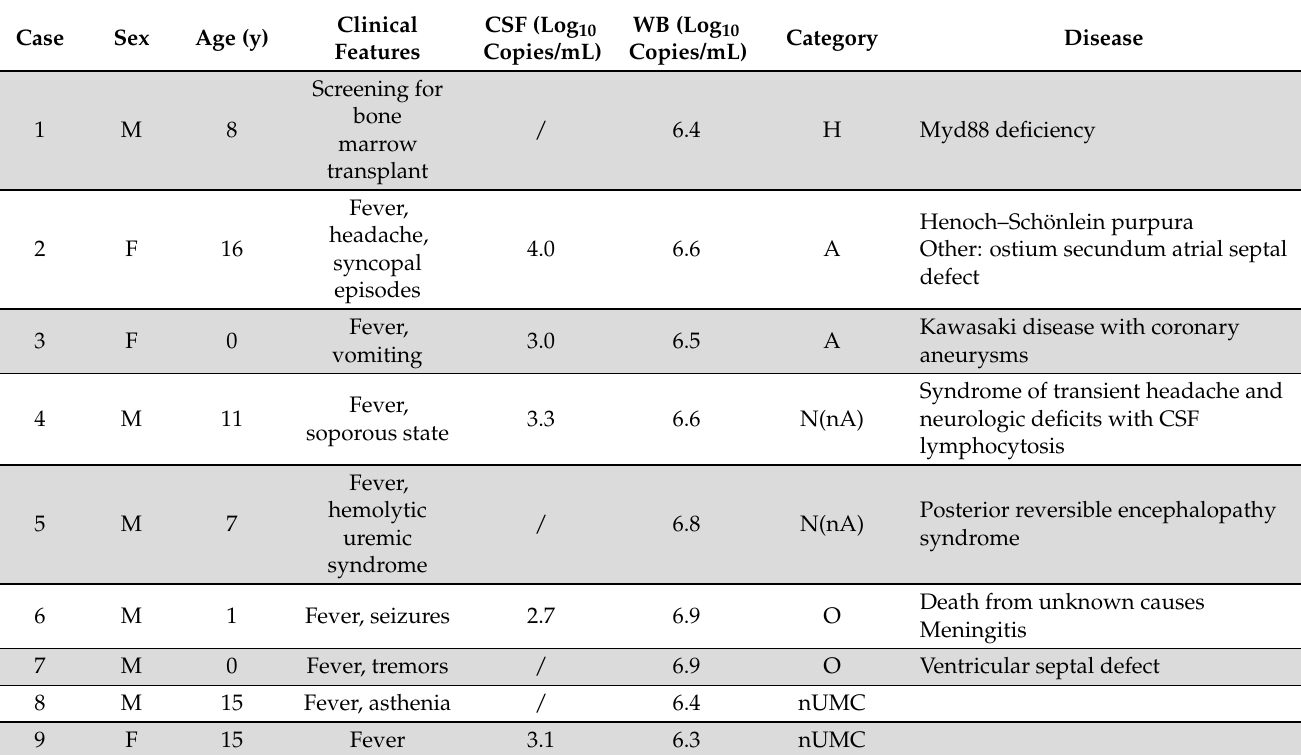
Table 3. Overview of the 16 iciHHV-6 pediatric patients: clinical features leading to HHV-6 investiga- tion, HHV-6 DNA load in CSF and WB and patients’